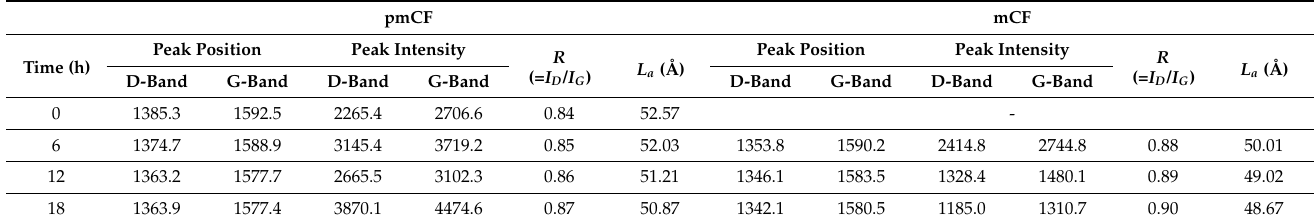
Table 3. Analysis of peaks of mPCFs depending on milling